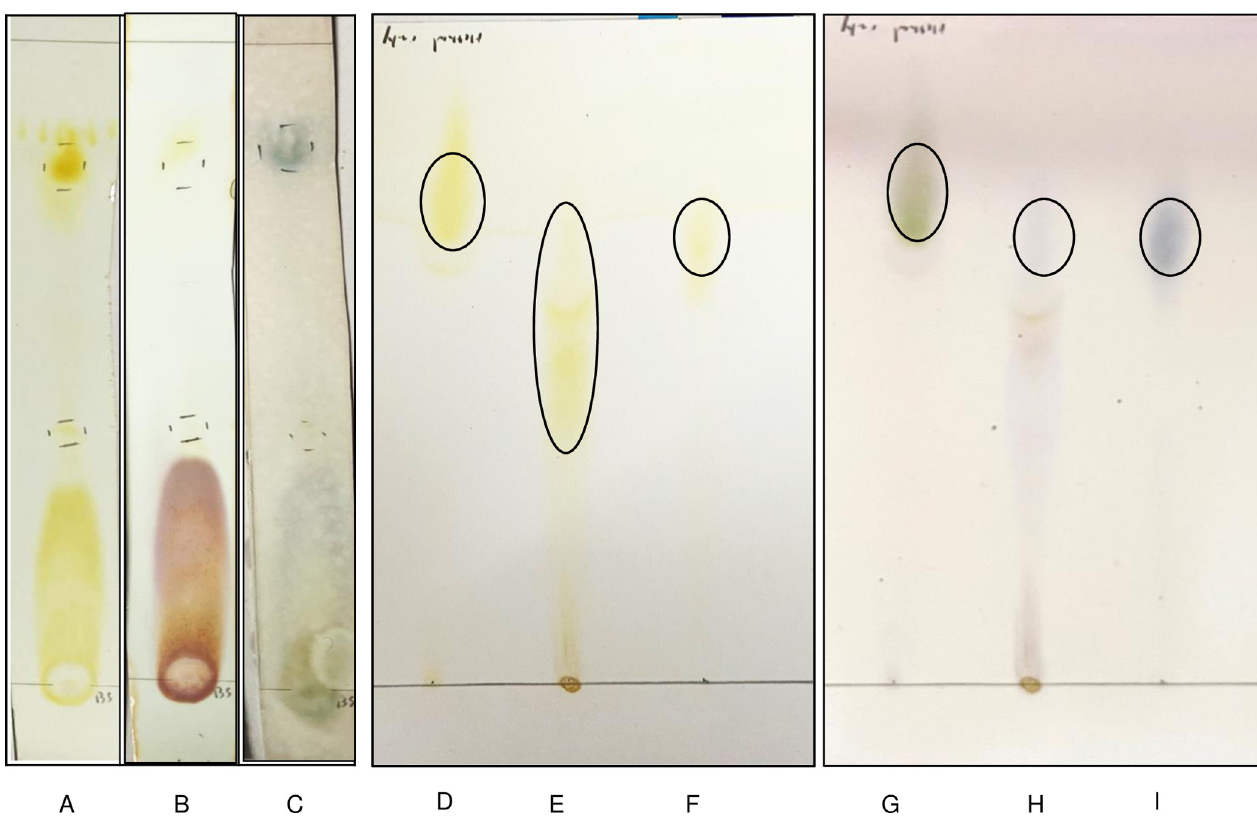
Fig 6. TLC characterization of biosurfactant. Left panel: Crude biosurfactant (A) stained with iodine (B) stained with ninhydrin (C) stained with p- anisaldehyde. Middle panel: Iodine staining for lipid detection (D) control rhamnolipid (E) crude biosurfactant (F) purified biosurfactant. Right panel: p- anisaldehyde staining for carbohydrate detection (G) control rhamnolipid (H) crude biosurfactant (I) purified biosurfactant.